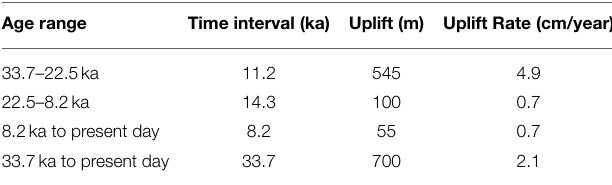
TABLE 2 | Uplift and uplift rates for Samosir, Toba since